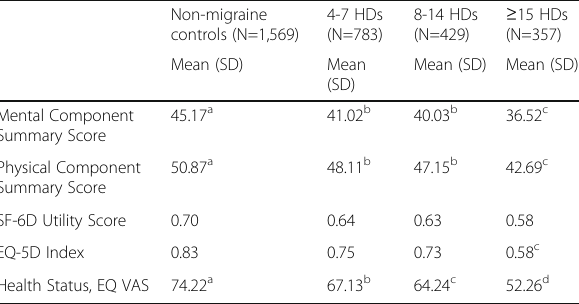
Table 1 (abstract P40). HRQoL outcomes in NHWS respondents with migraine versus matched controls* Non-migraine controls